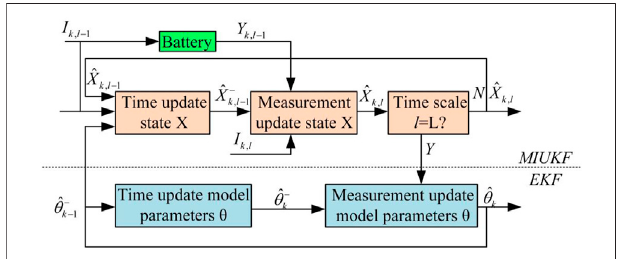
FIGURE 2 | Flowchart of the MIUKF-EKF